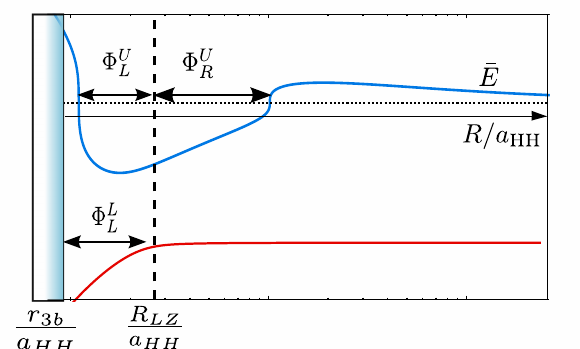
/ 3 ( R / a ) with a > 0 HH HH ν 2 , and the m H a 2 HH